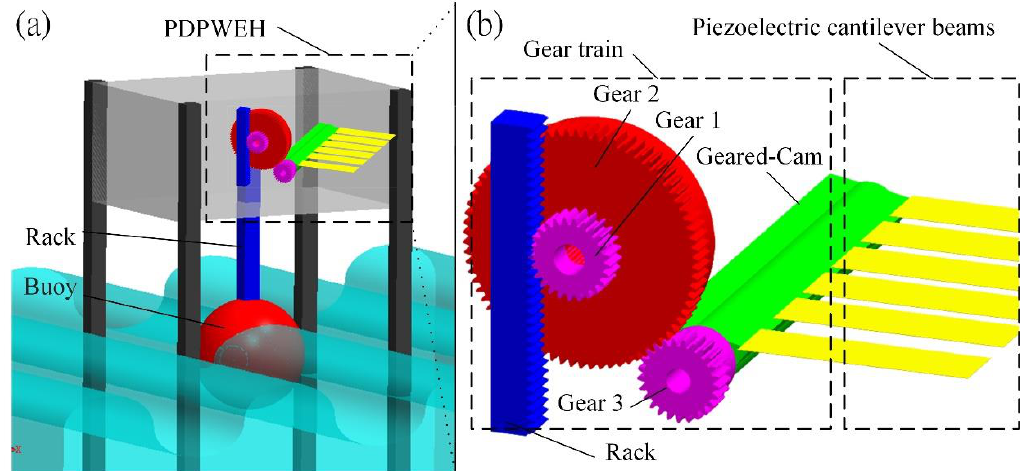
Figure 1. Schematic diagrams of Piezoelectric Wave Energy Harvester. ( a ) Plucking-driven Piezoelectric Wave Energy Harvester. ( b ) Gear train frequency up-conversion mechanism and an array of piezoelectric cantilever beams.